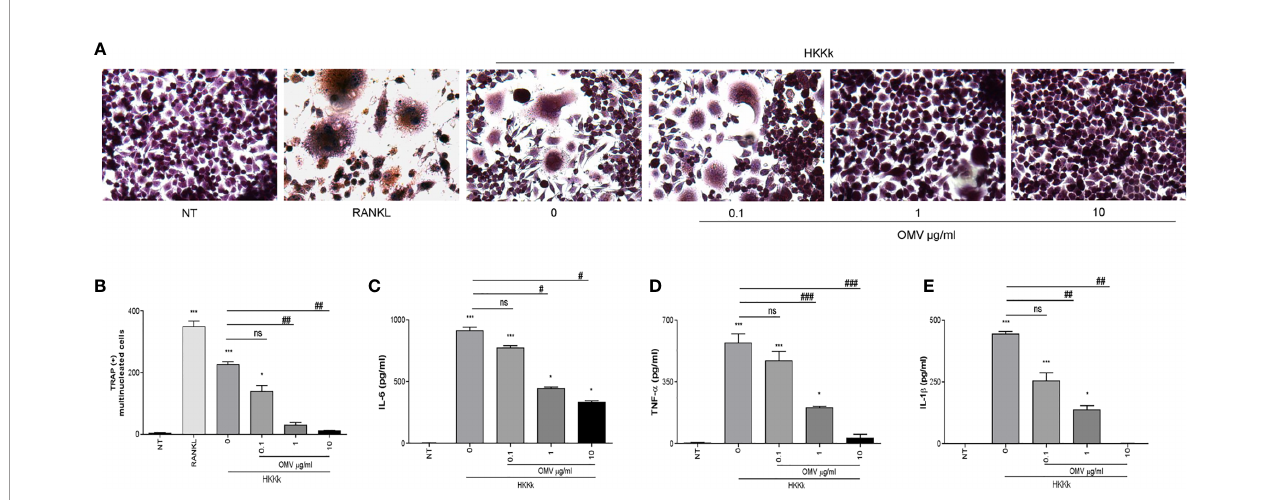
FIGURE 7 | Outer membrane vesicles (OMV) pretreatment decrees osteoclastogenesis induced by HKKk in a dose-dependent manner. RAW 264.7 cells were stimulated with culture supernatants from HKKk-stimulated THP-1 monocytes (1 × 10 6 bacteria/ml) pretreated with OMV (0, 0.1, 1, and 10 µg/ml) added at a 1:2 proportion in conjunction with macrophage colony-stimulating factor. After 7 days, osteoclastogenesis was determined by the generation of multinucleated TRAP- positive cells (more than three nuclei). Representative digital images were taken by light microscopy (A) , and TRAP-positive multinucleated cells were identi fi ed and counted (B) . RANKL was used as a positive control. NT, non-treated. IL-6 (C) , TNF- a (D) , and IL-1 b (E) were measured by commercial ELISAs in culture supernatants from THP-1 cells collected at 24 h post-stimulation. Graphics are showing values obtained from three independent experiments. Data are given as